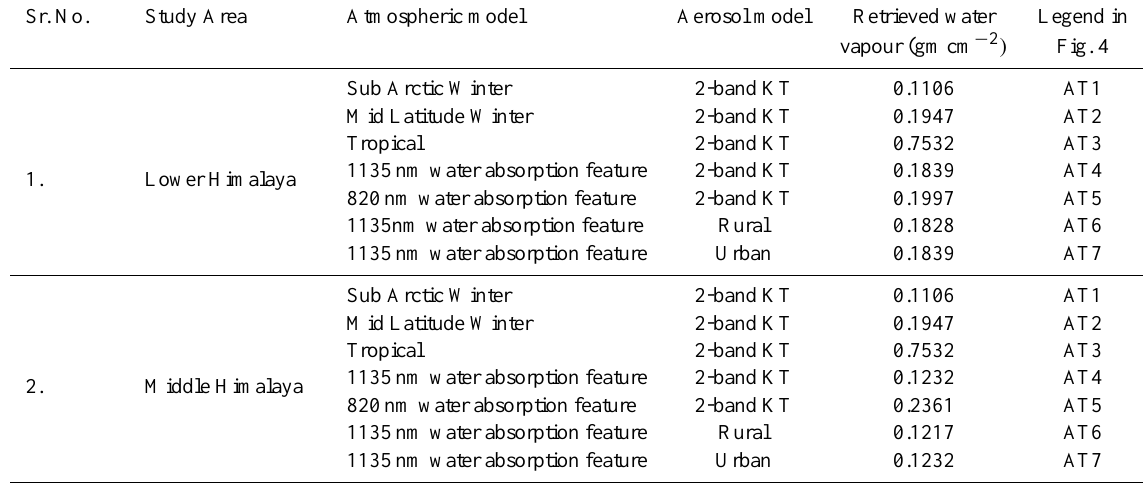
Table 2. The atmospheric correction using different atmospheric and aerosol models for the Hyperion images of the study area. Sr. No.